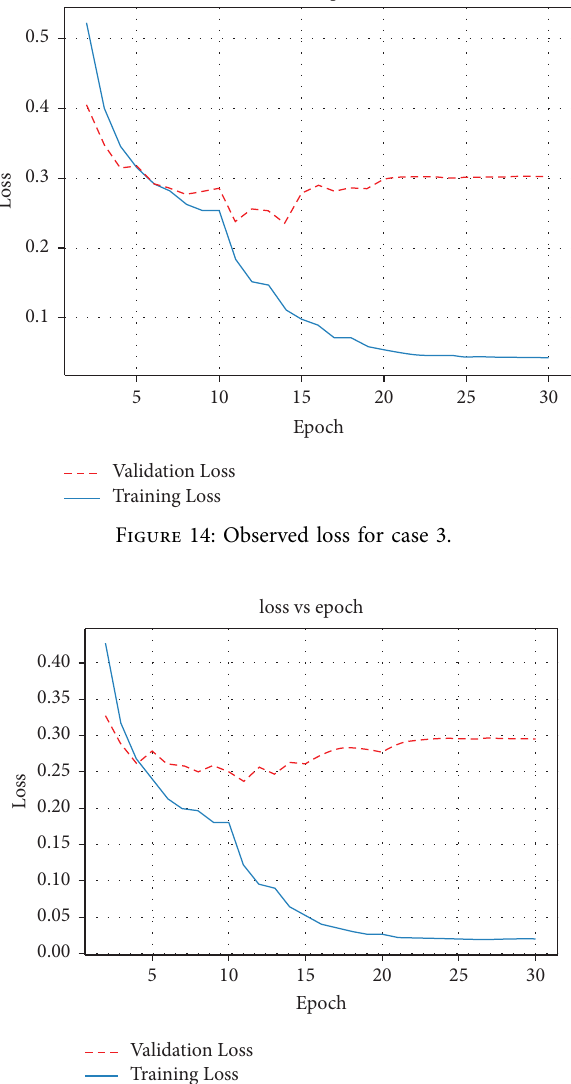
Figure 15: Observed loss for case